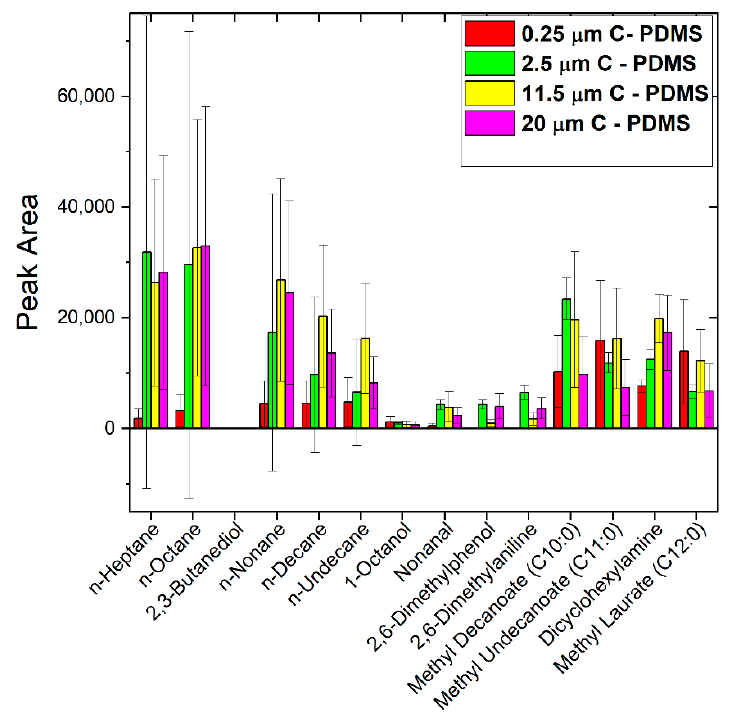
Figure 4. Comparison of HS – SPME – GC – MS results of sputtered SPME fibers with different carbon thicknesses. These fibers were also coated with PDMS. n = 3 for each compound, and y-error bars represent standard deviations.